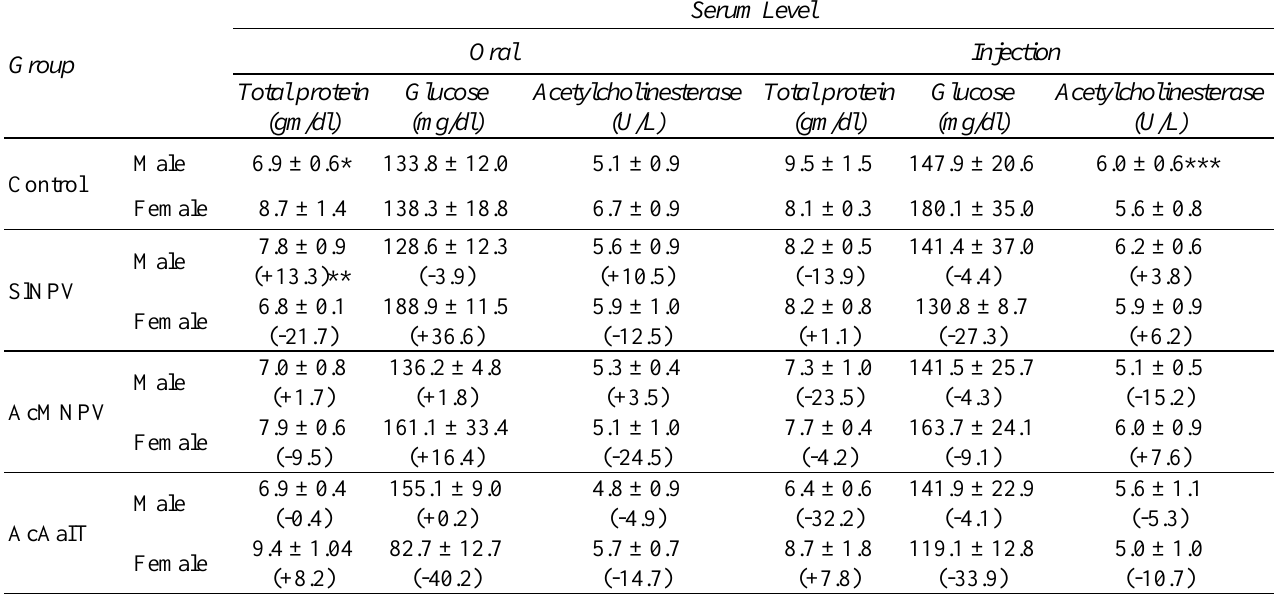
Table 7: Levels of total protein, glucose, and acetylcholinesterase in rat serum at 21 days after oral or intraperitoneal administration of SlNPV, AcMNPV or AcAaIT